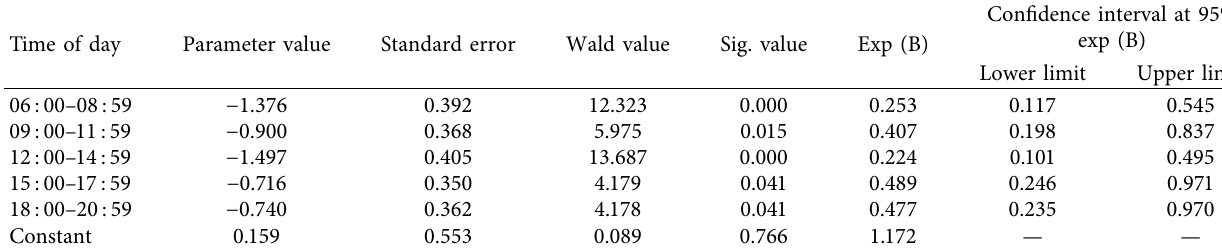
Table 6: Estimation result of parameters.